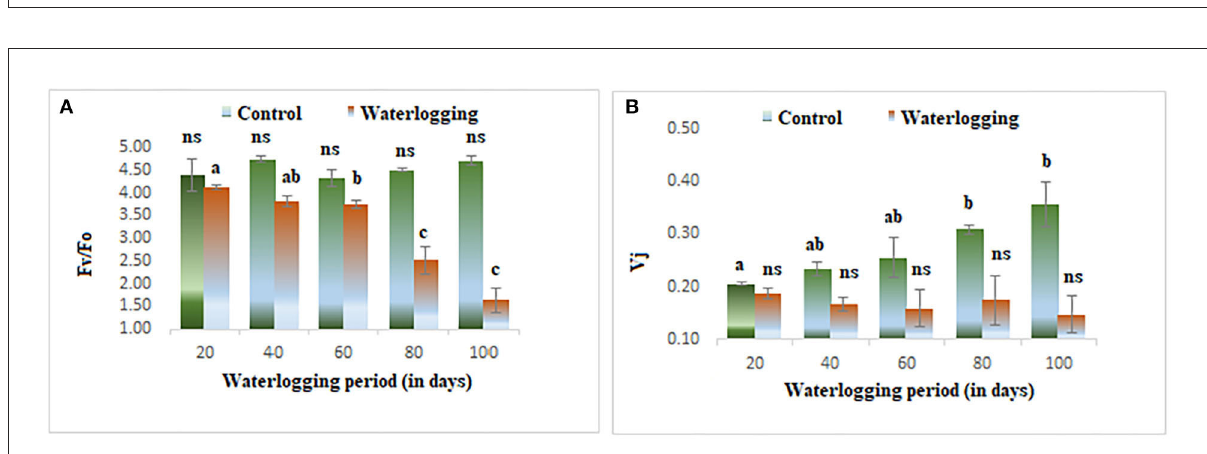
FIGURE3 Waterlogging-induced changes in different fluorescence parameters (A) Fo (B) Fm (C) Fj (D) Fi. The letters are the result of post hoc test.